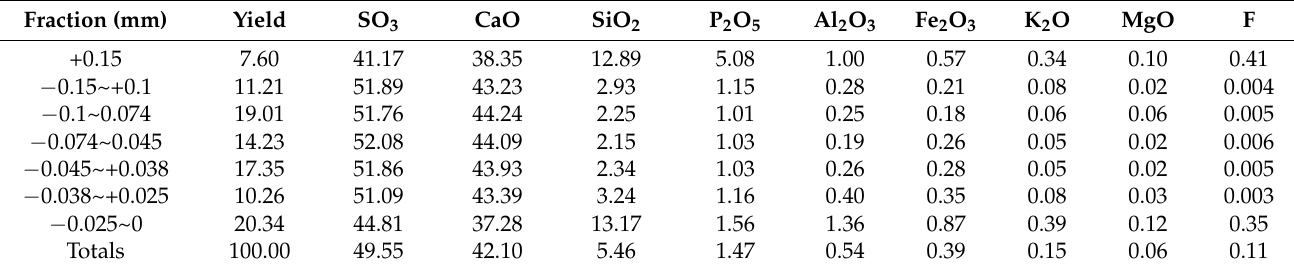
Figure 1. XRD patterns of the phosphogypsum ( a ) and the different grain-sized products ( b ). Table 2. Grain-sized analysis of phosphogypsum (mass fraction,